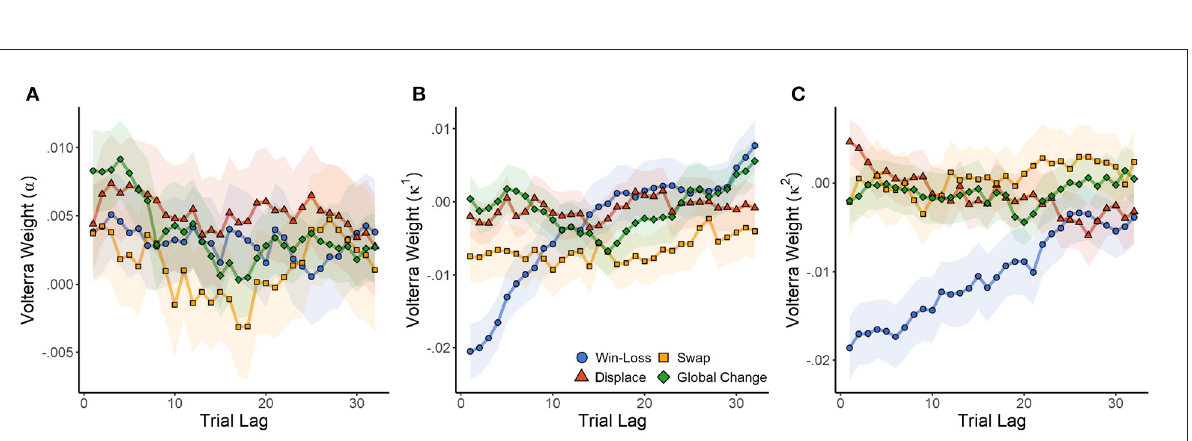
FIGURE6 Effect of wins, local, and global changes in choice position on Q-learning parameters α (A) (learning rate), κ 1 (B) (reward strength), and κ 2 (C) (punishment strength). The influence of wins and cue rearrangement during the previous 32 trials is estimated by Volterra decomposition, which provides a weight (loading) for each trial lag. SEM in shaded